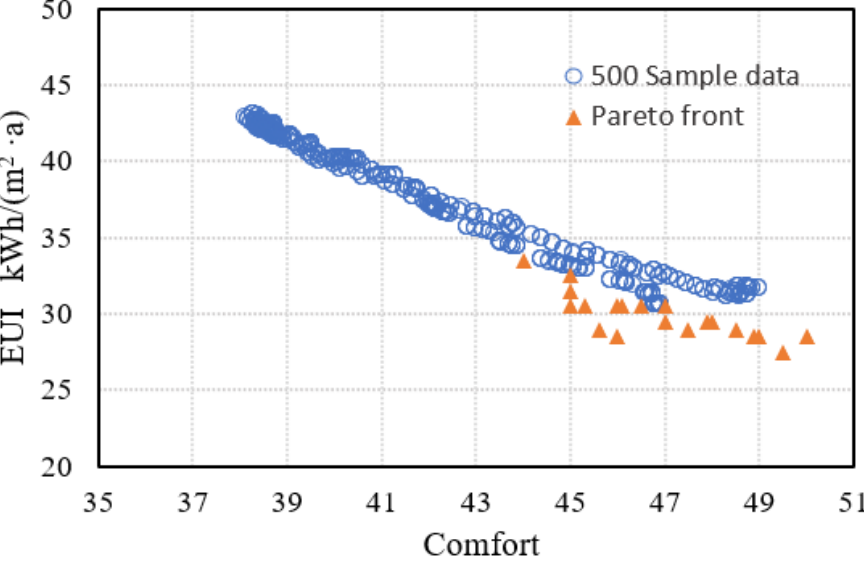
Figure 14. EUI and comfort value of 500 sample data and Pareto-front solutions.